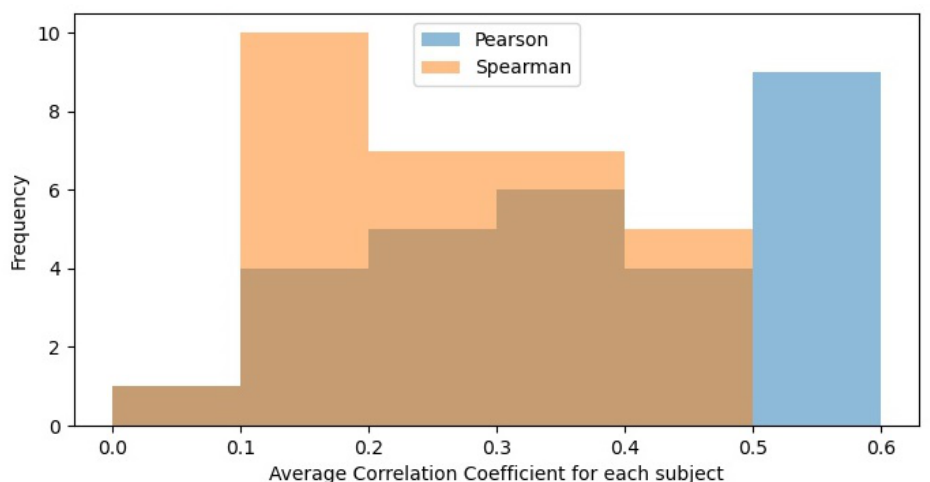
Figure 4. Histogram of correlation coefficients on all participants of SAMM-LV and SAMM-SYNTH. Both histograms use 6 bins. We observed that Spearman’s coefficients are more right-skewed relative to Pearson’s coefficient. This implies that our results are more linear than monotonic correlated.